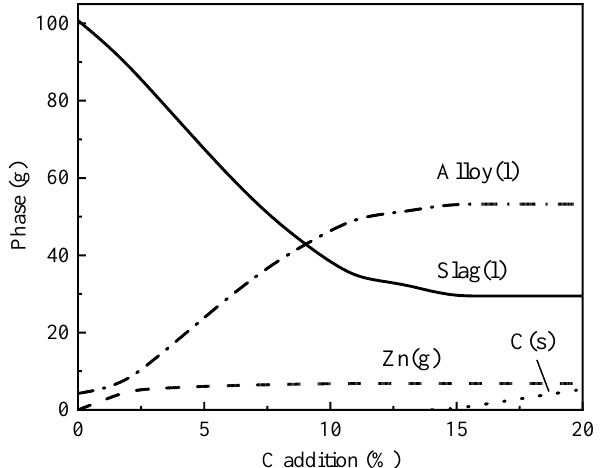
Figure 5. Effect of carbon addition on the amounts of the phases during reduction at 100g slag, 1400 °C and 5% CaO addition.